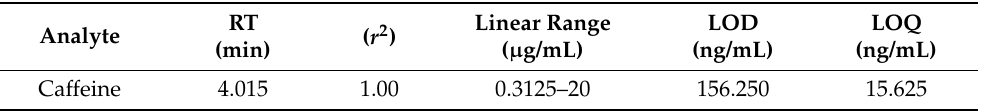
Table 5. Correlation coefficient ( r 2 ), linear range, LOD, and LOQ of the caffeine standard in the anti-cellulite emgel analyzed by